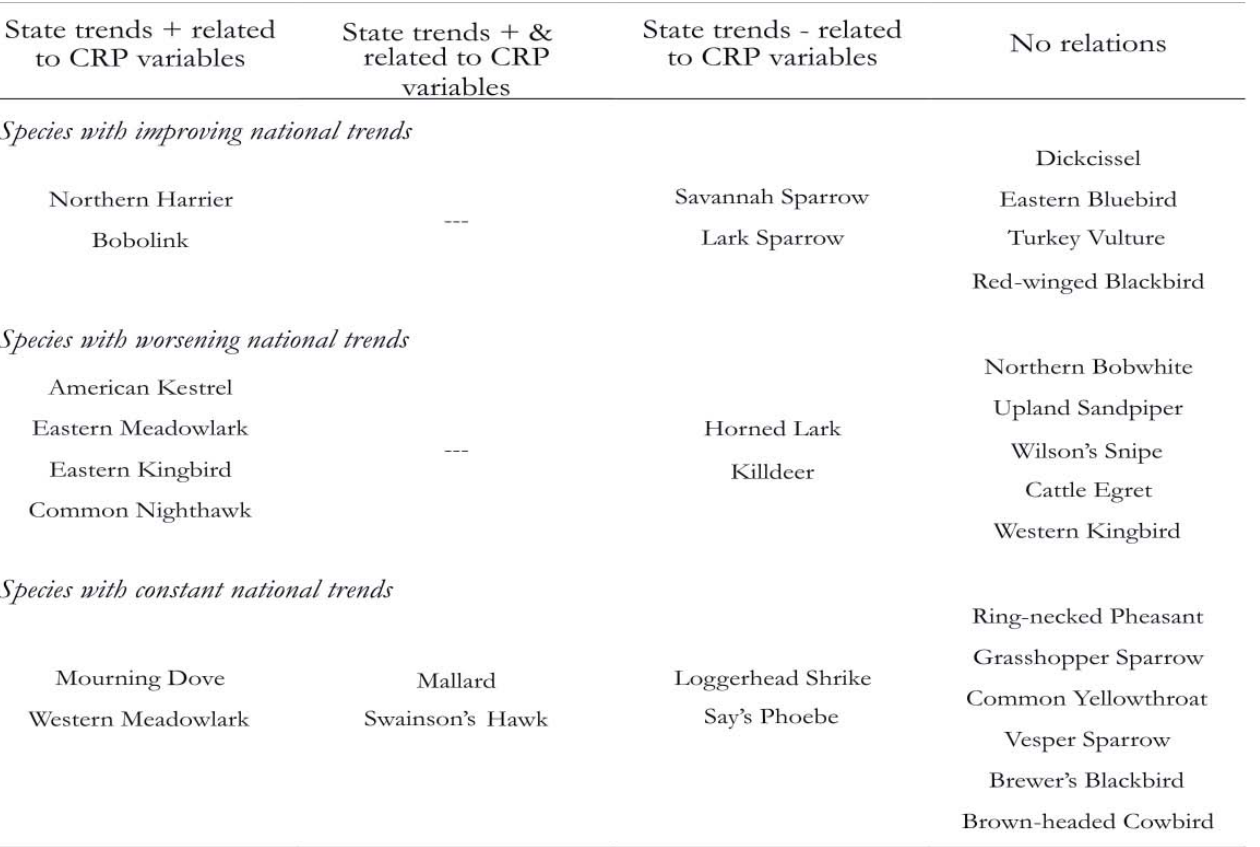
Table 3. Summary of national trend changes (pre- vs. post-CRP) and state-level relationships to CRP variables for spe- cies that were involved in the state-level